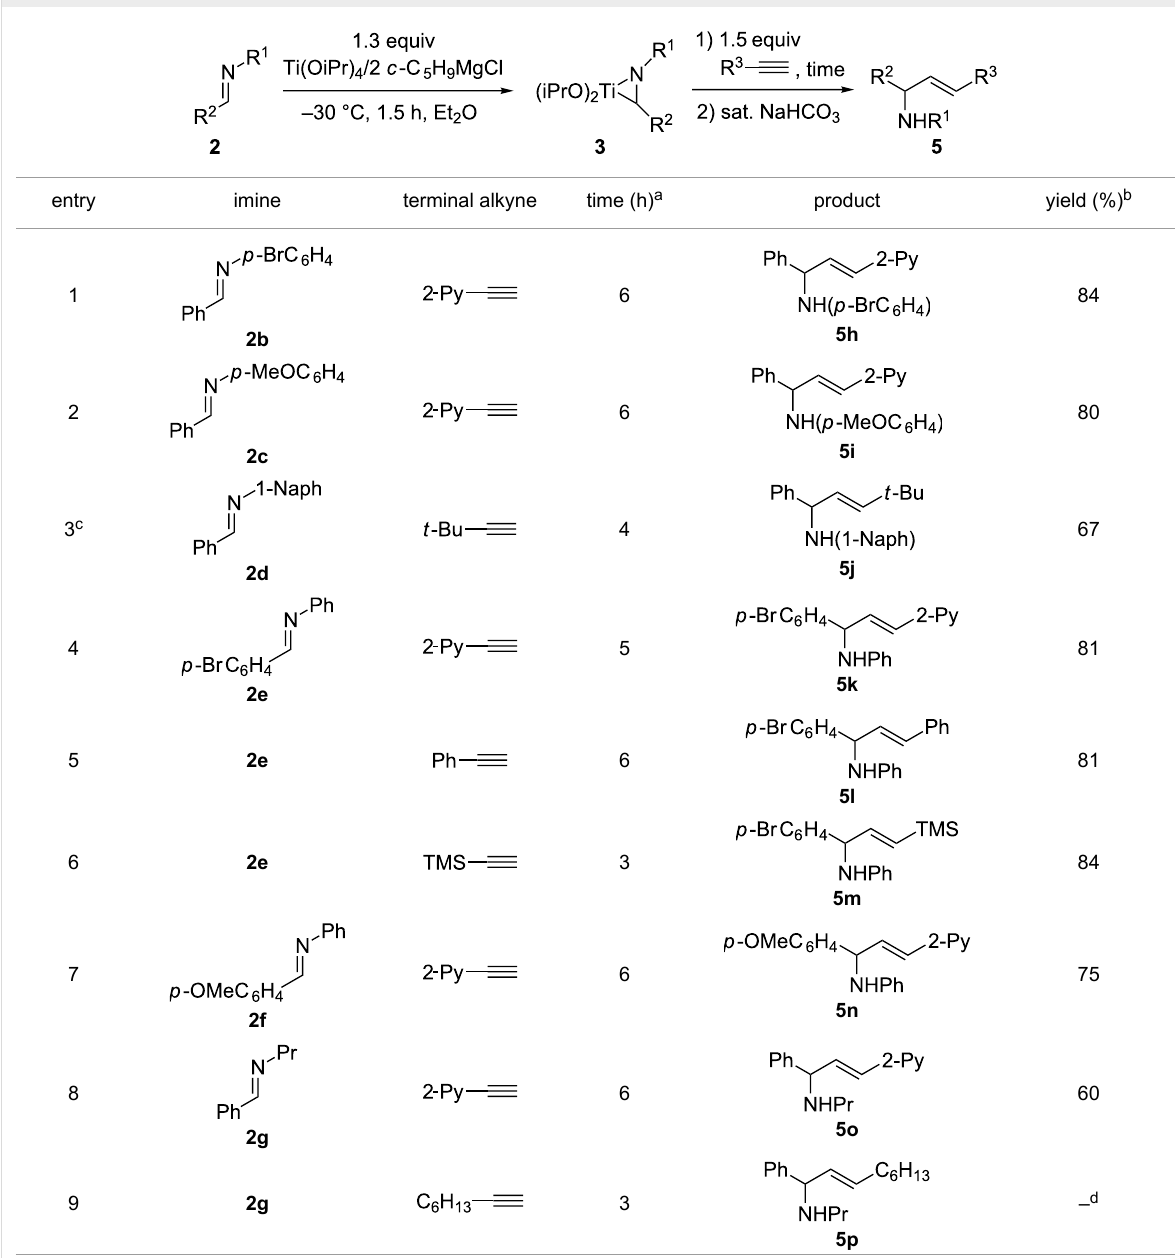
Table 2: Synthesis of various allylic amines by titanium-mediated coupling reactions of different imines with terminal